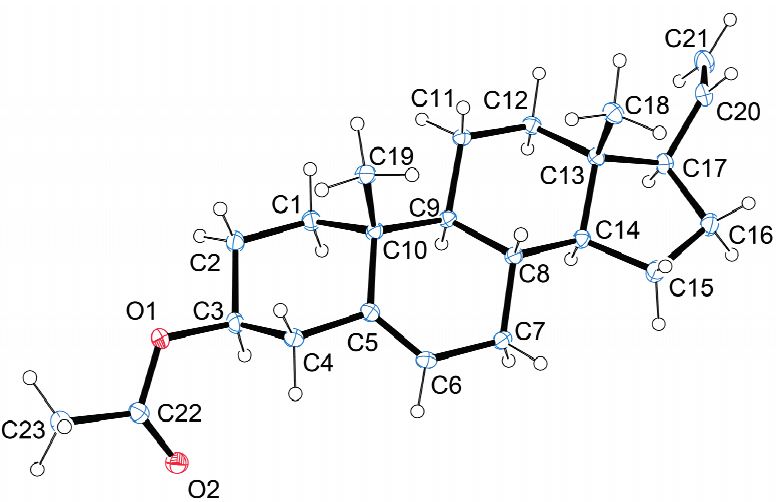
Figure 2. Molecular plot of 2 with confirmed absolute